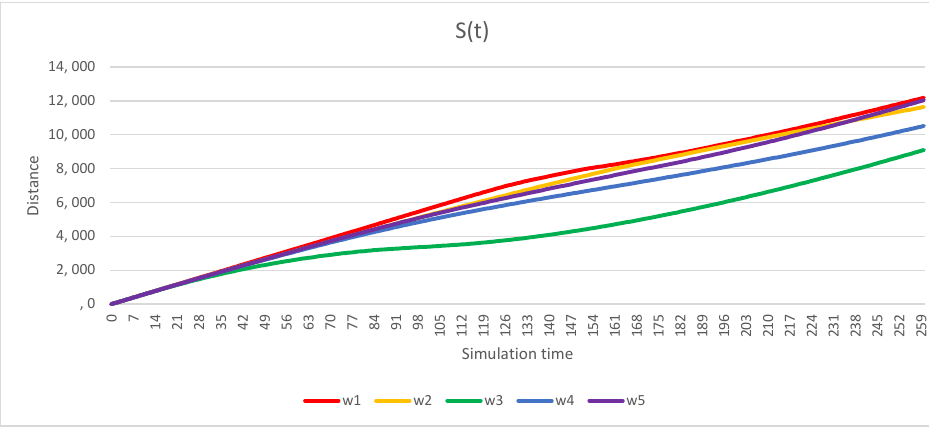
Figure 11. Velocity change V ( t ) in simulation by context 3 for distance D 0 = D gr = 5000 m.